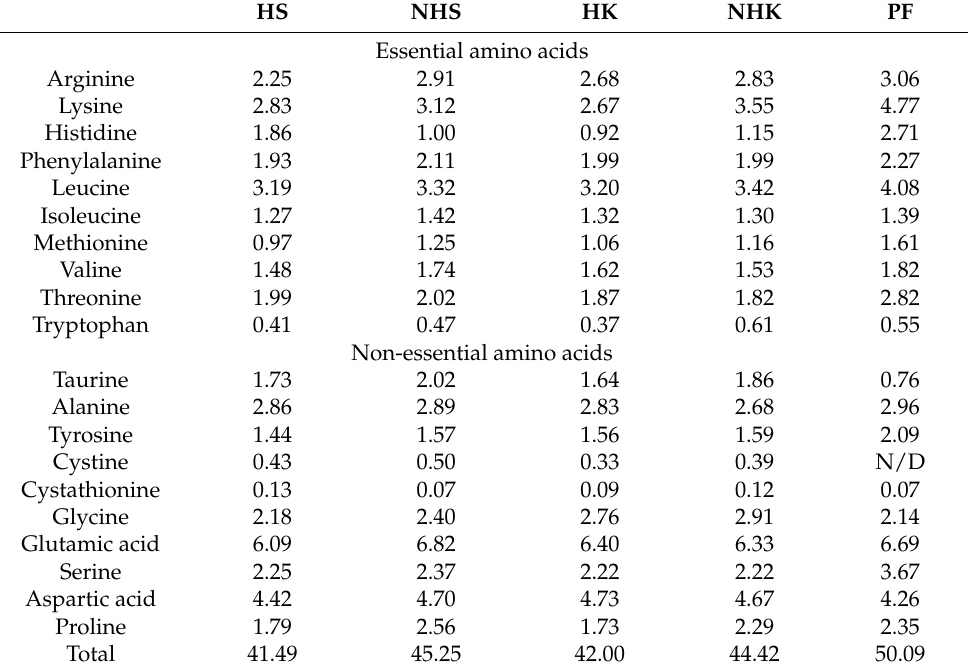
Table 2. Total amino acid content of the test diets (g/100 g, dry-weight).